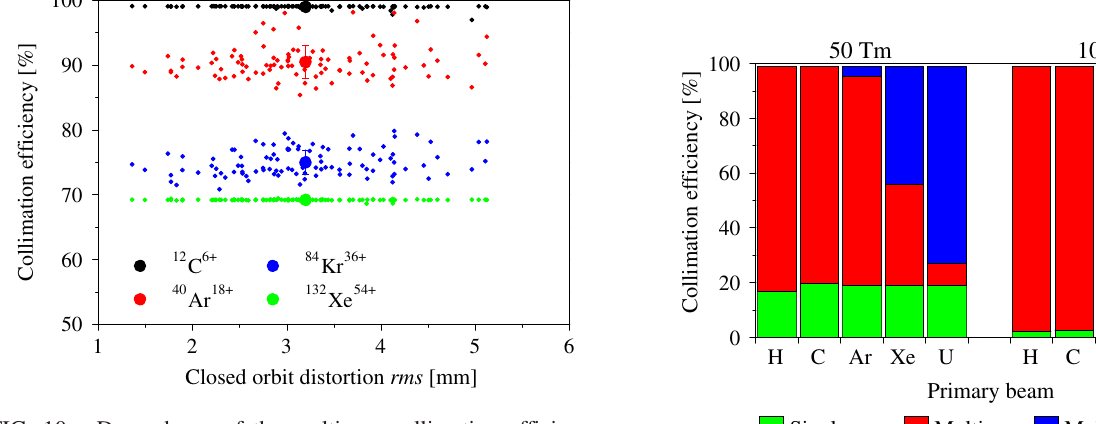
FIG. 10. Dependence of the multipass collimation efficiency without cryocatchers on the closed orbit distortion. The small circles are the individual error seeds. The big circles are the arithmetic mean values of the COD and efficiency. The error bars are the standard deviations for the efficiency.